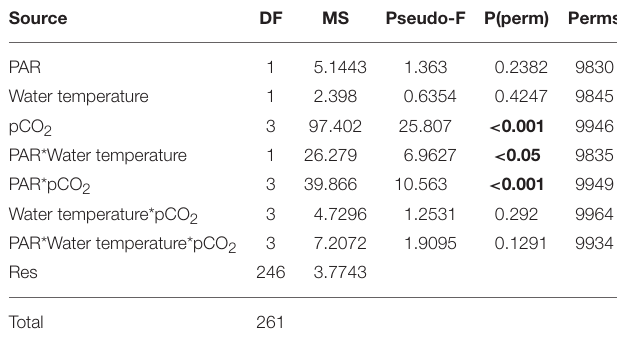
TABLE 5 | Results of PERMANOVA analysis on the separate and interactive effects of pCO 2 , PAR, and water temperature on the net primary production rate of Zostera marina in